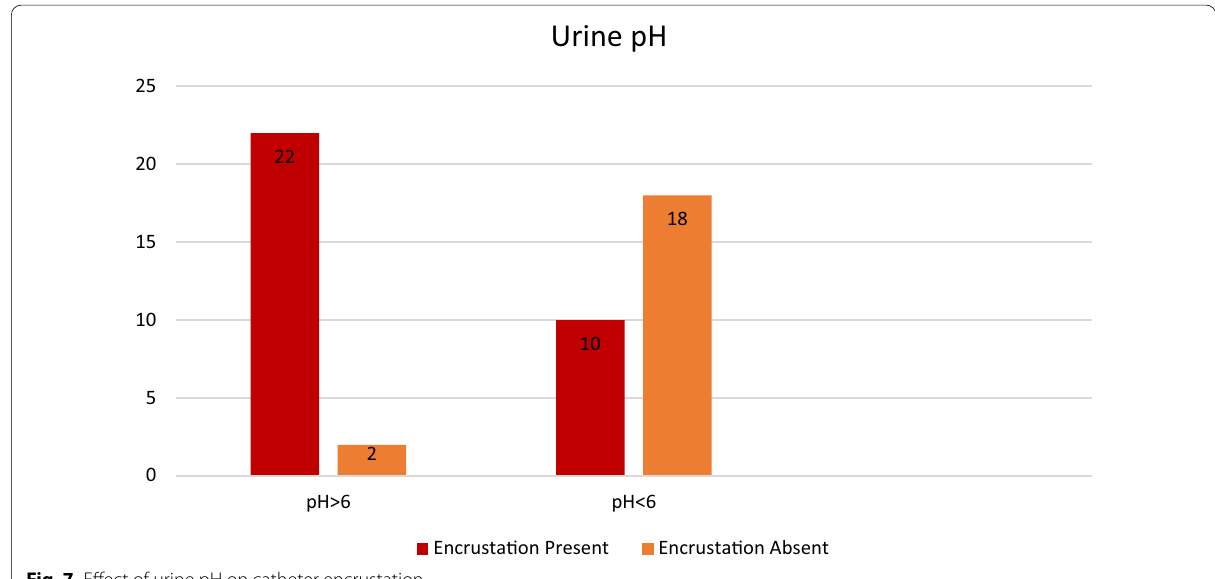
Fig. 7 Effect of urine pH on catheter encrustation